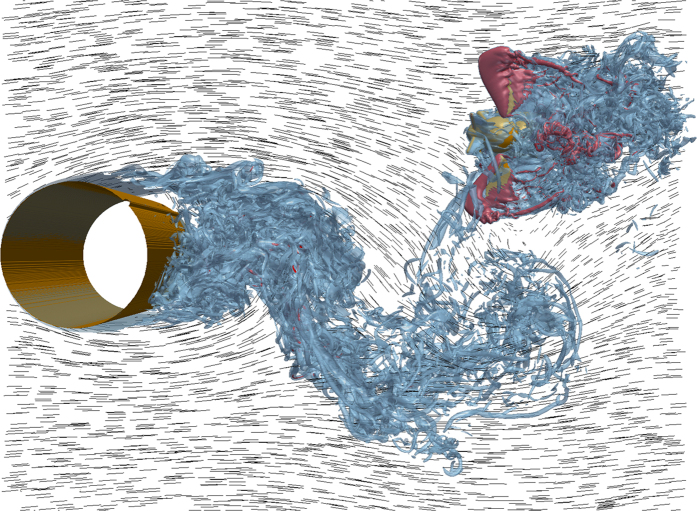
Birds eye view of the flow field obtained with numerical simulation.Isosurfaces of dimensionless vorticity magnitude are shown as, light blue |ω| = 5, red |ω| = 40. Thin lines show the velocity in the horizontal plane that passes through the insect’s center of gravity. The insect is colored in orange. Flow is shown at t = 246.1 ms after the beginning of the simulation.